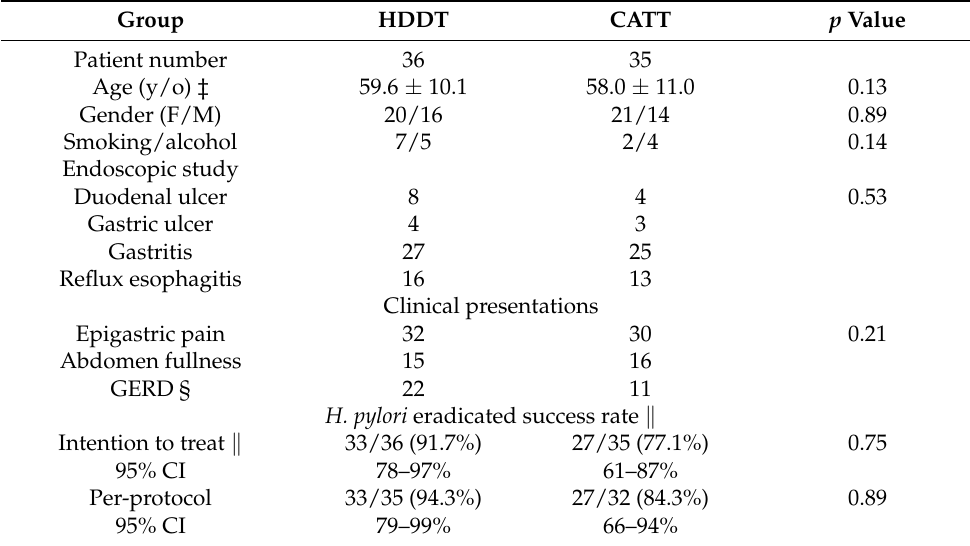
Table 1. Demography and study results.